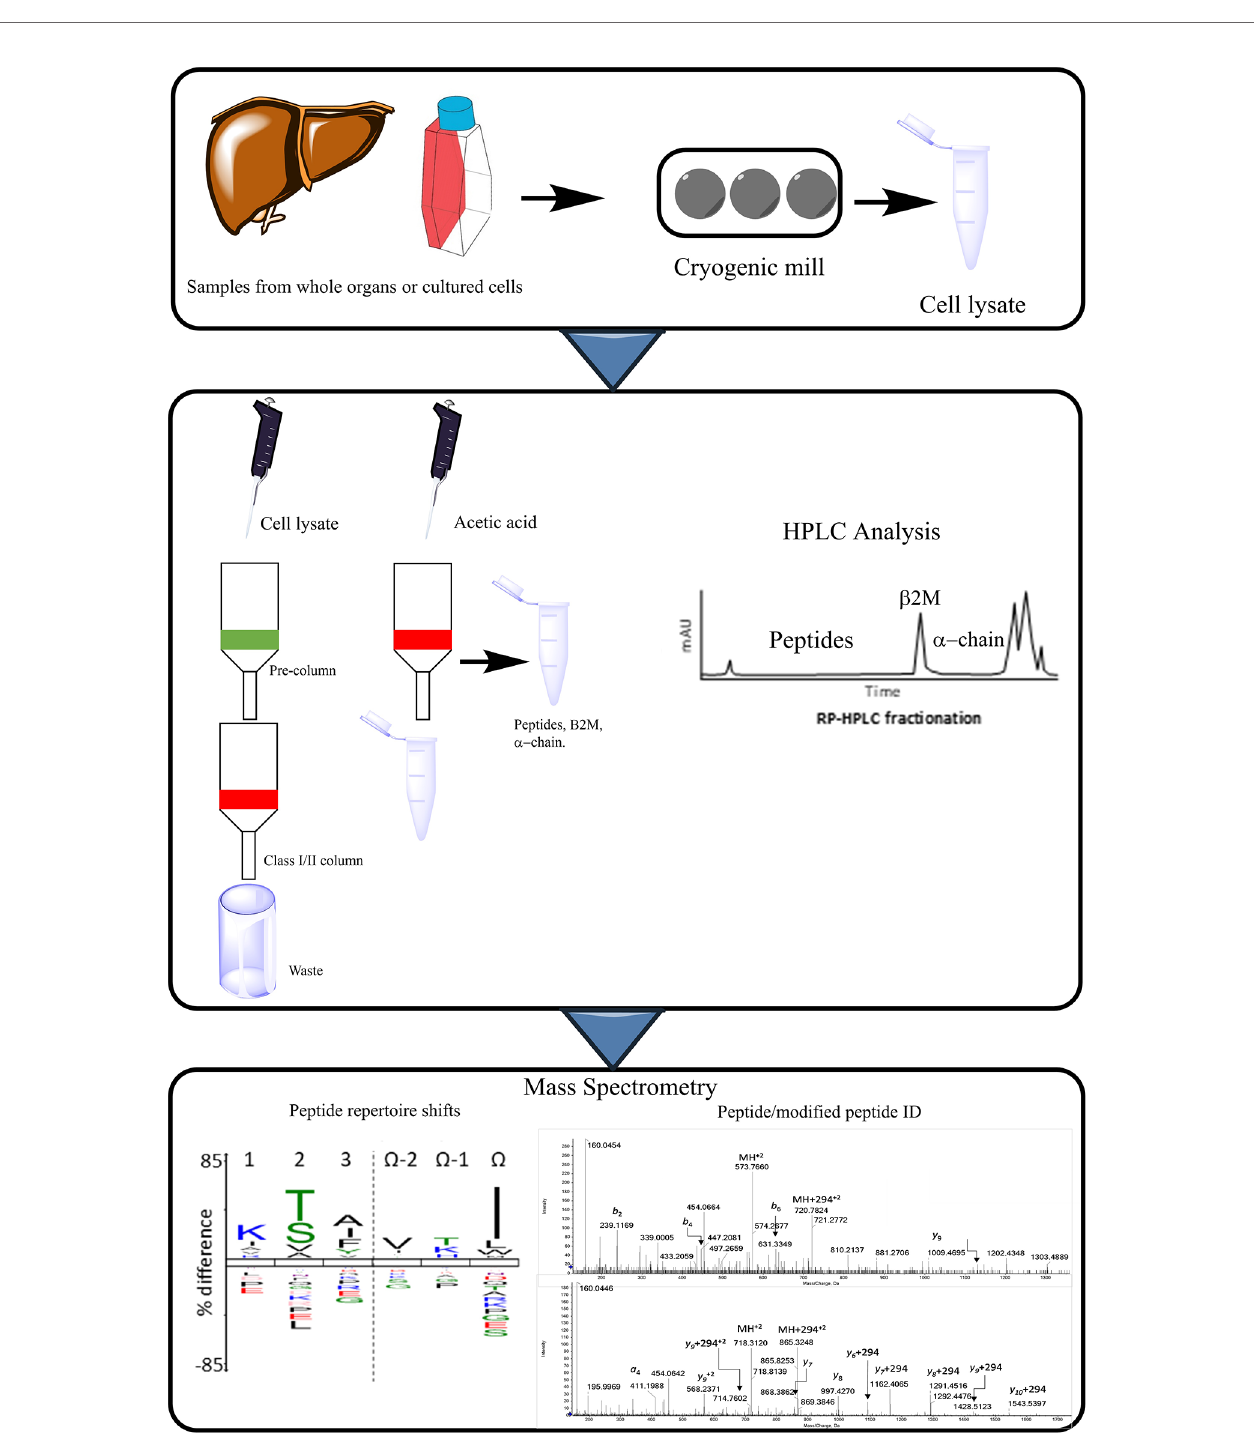
FIGURE 9 | Procedural work fl ow of peptide elution assays. MHC complexes are puri fi ed from the samples, which can comprise of cultured cells (i.e. transfected B-cells expressing HLA allele of interest), or cells deriving from whole organs or biopsies (liver). Cell pellets can be ground using cryogenic mill and are then lysed. Immunoprecipitation takes place from the cell lysate, this occurs through running the sample through columns speci fi c for the MHC in question, as well as a pre- column to remove non-speci fi c binding. HPLC is then conducted to separate the MHC peptides from the larger components such as b 2 M and the alpha chain. Pooled fractions can then be analyzed via m/s allowing for the identi fi cation of modi fi ed peptides or an altered repertoire of peptides presented to